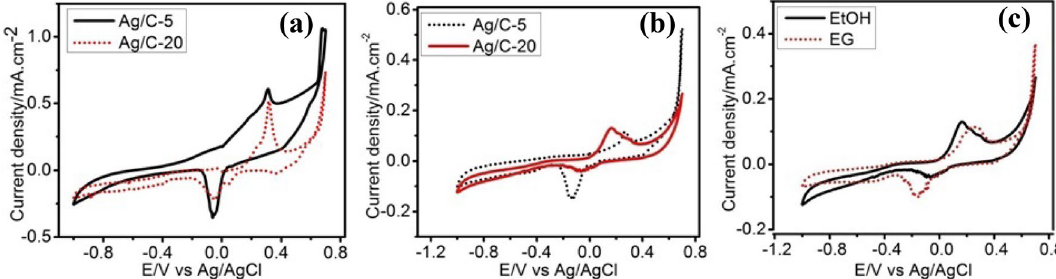
Fig. 3 a CV of Ag/C-5 and Ag/C-20 at 0.5 M NaOH at 100 mV s −1 scan rate at 25 °C, b CV of Ag/C-5 and Ag/C-20 at 0.5 M NaOH + 1 M EtOH at 100 mV s −1 scan rate at 25 °C, c CV of Ag/C-20 at 0.5 M NaOH + 1 M EtOH and 0.5 M NaOH + 1 M EG at 100 mV s −1 scan rate at 25